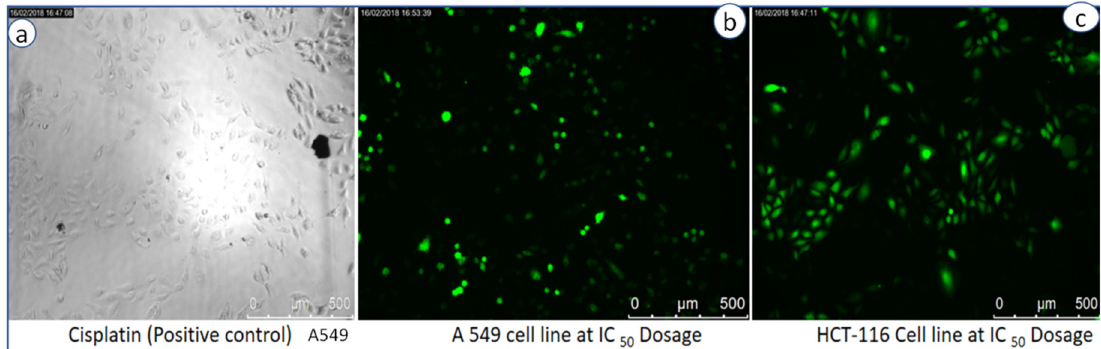
Figure 8. ROS fluorescence microscopy images of ( a ) cisplatin (positive control), ( b ) A549 cell lines, and ( c ) HCT 116 cell lines at IC 50 dosages.